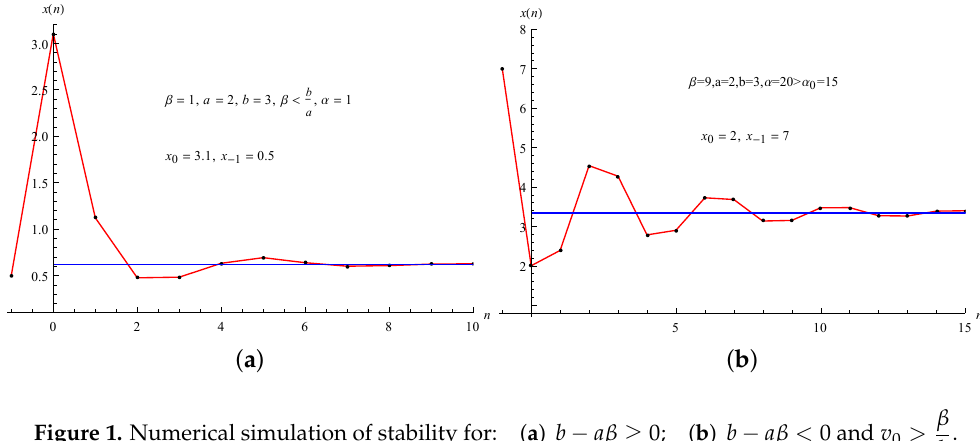
Figure 1. Numerical simulation of stability for: ( a ) b − a β ≥ 0; ( b ) b − a β < 0 and v 0 > For the case of v 0 =